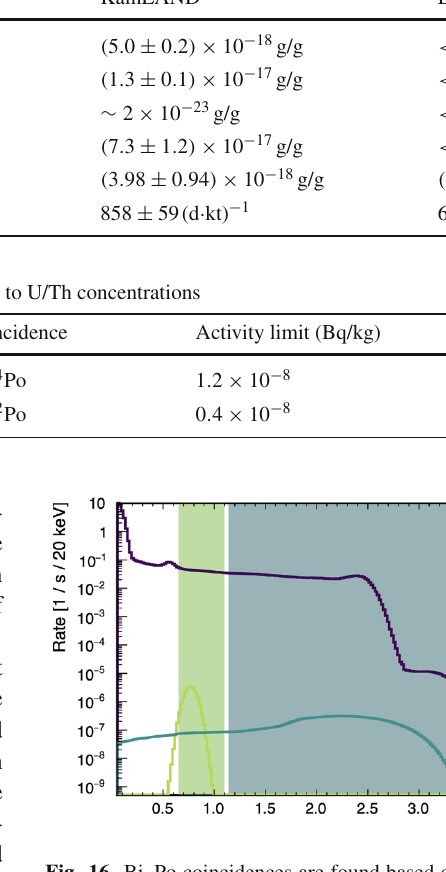
Note that the limit on 85 Kr is quoted in maximum activity per LS mass (per day and kiloton) Chain/isotope